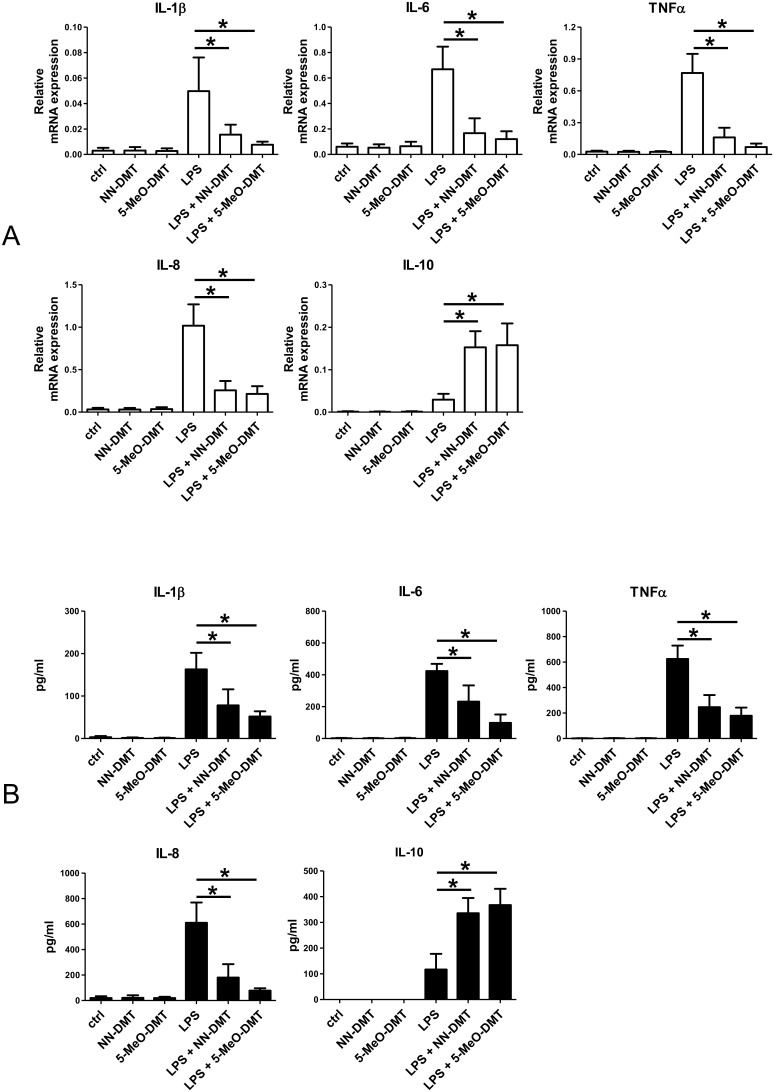
Effects of NN-DMT and 5-MeO-DMT treatment on the gene expression and secretion of cytokines and chemokines in LPS-stimulated moDCs.
A: MoDCs were incubated with 100 µM NN-DMT (NN-DMT) or 5-MeO-DMT (5-MeO-DMT) for 8 h or left untreated (ctrl) were used as controls. Additionally, cells were either activated with 500 ng/ml LPS alone for 8 h, or pre-treated with tryptamines for 1 hour and subsequently were activated with LPS for 8 hours (LPS+NN-DMT; LPS+5-MeO-DMT). The expression of IL-1β, TNFα, IL-6, IL8, and IL-10 was assessed by real-time Q-PCR and shown as relative mRNA expression. Results represent the Mean ± SEM of 4 independent experiments. B: Cytokine profile of cells treated as above. Supernatants of DC cultures were collected after 24 h and were subjected to ELISA measurements. Concentration of the secreted cytokines and chemokines are shown as Mean ± SEM values of 4 independent donors. (*) means statistical significance as p<0.05.